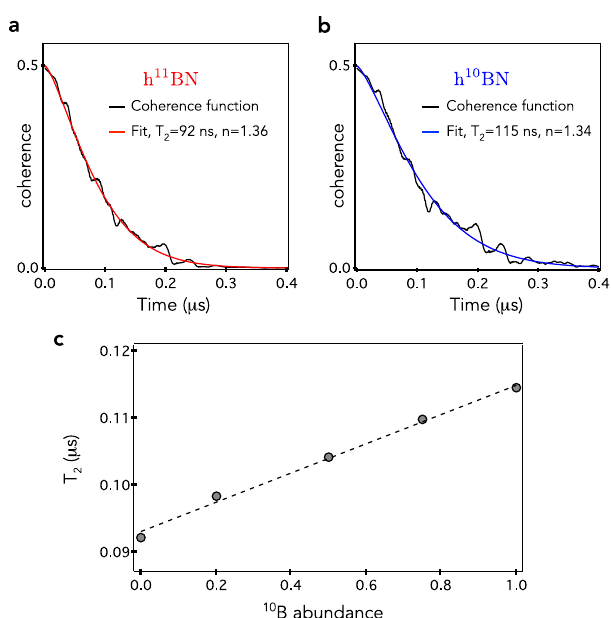
Fig. 4 Nuclear spin bath induced decoherence. a , b Simulated spin echo decay curve and corresponding stretched exponential fi t for the V (cid:1) in a h 11 BN and b h 10 BN. c Calculated spin coherence time T 2 as a function of the abundance of 10 B isotope. The T 2 time is enhanced by the reduced hyper fi ne and nuclear spin-nuclear spin interaction strengths in 10 B-enriched samples. The black dashed line is a linear fi